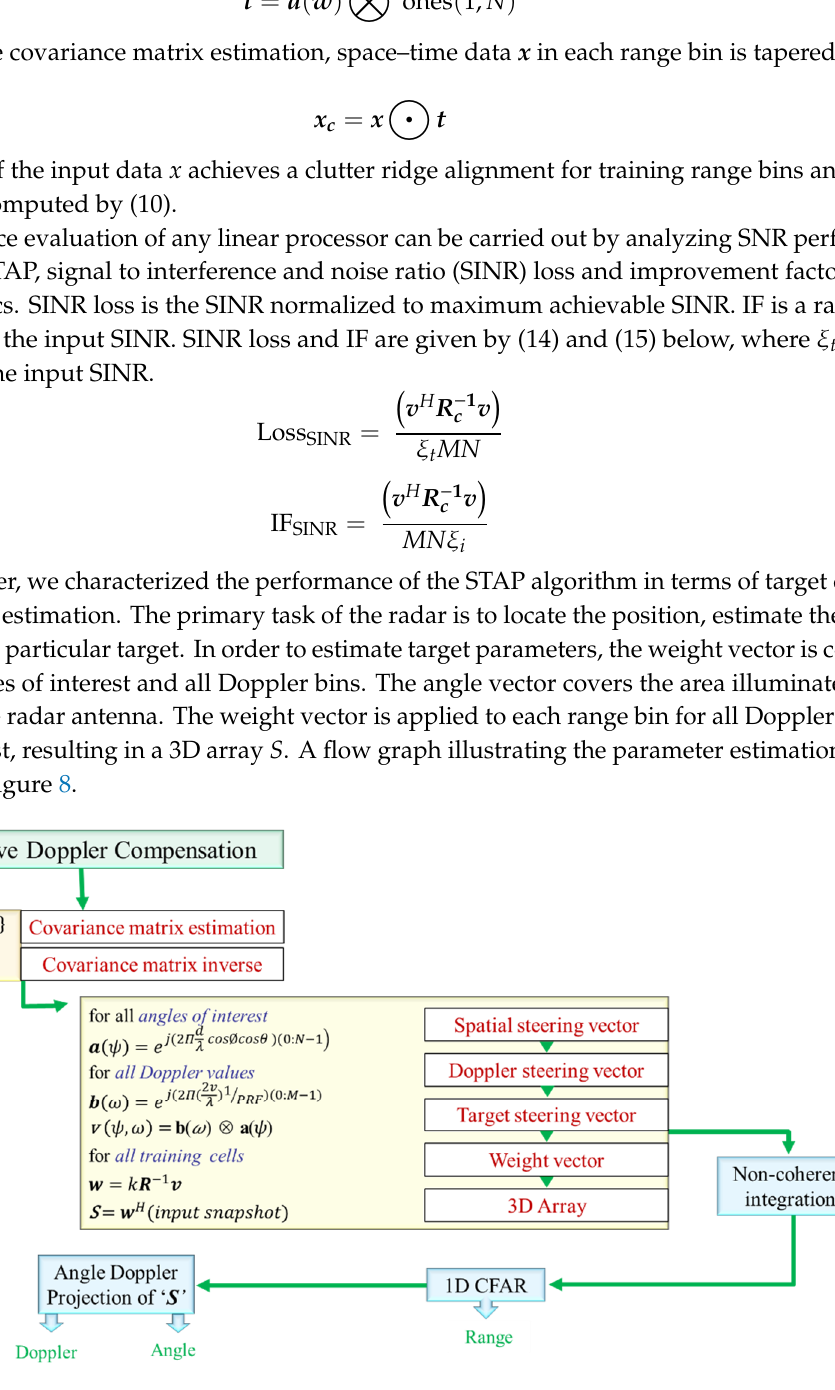
Figure 8. Target parameter estimation.